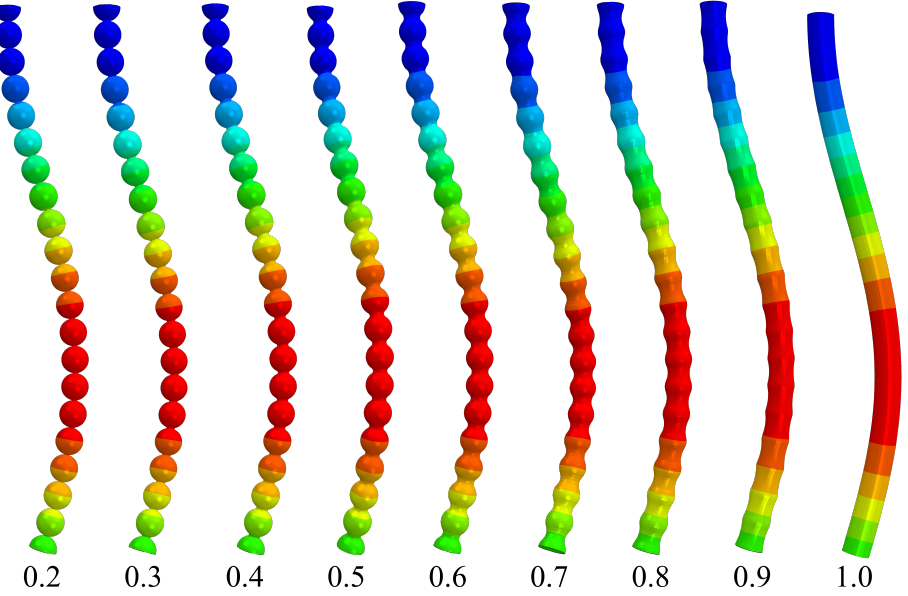
Figure 7. Finite element simulation results for the displacement states of the model pore walls in the deformed state under buckling for different ratios of neck size x to particle radius R , x / R